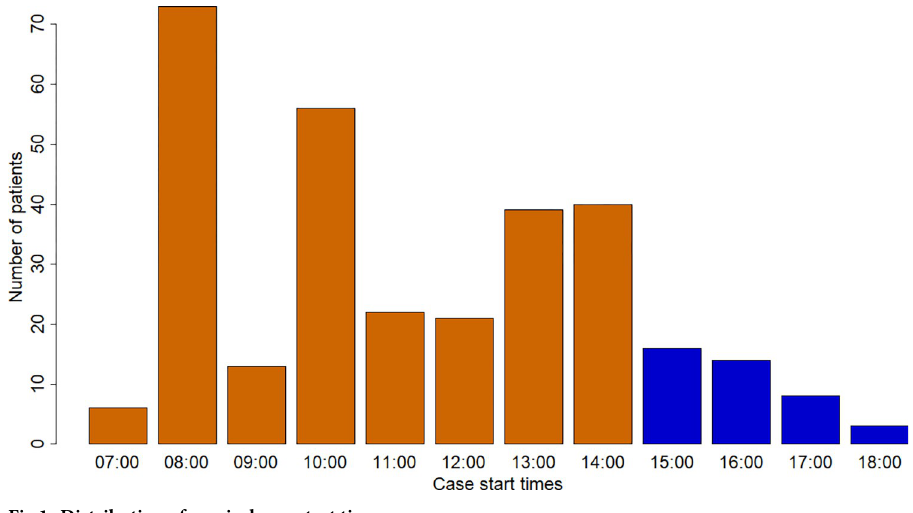
Fig 1. Distribution of surgical case start